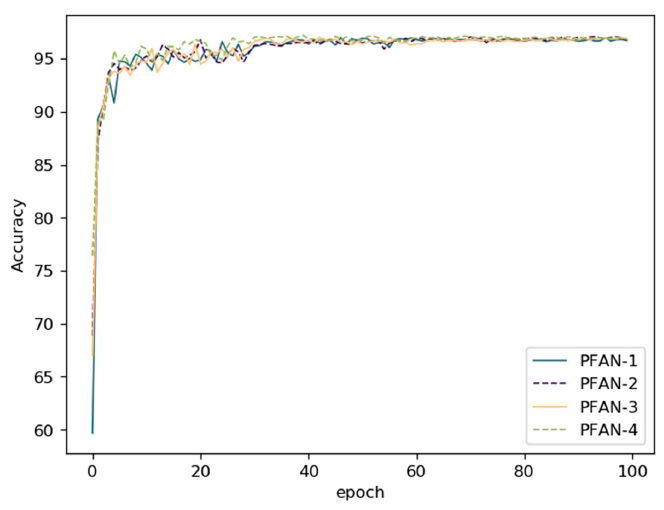
Figure 12. The training accuracy curves on GTSRB in the ablation